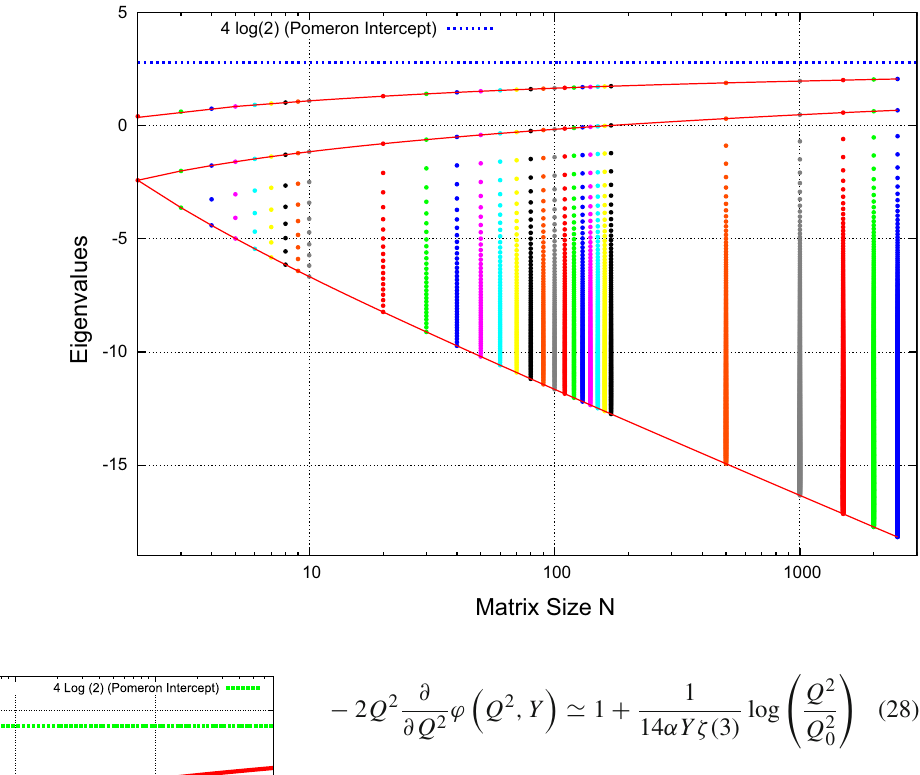
Fig. 7 Dependence of the eigenvalues on the matrix size N